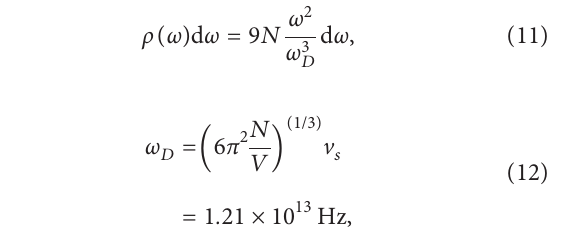
/ z R ) � 1 . 619 s − 1 , 〈 ζ 〉 � 156 . 5 , ( a / 〈 ζ 〉) � 0 . 85, is shown in blue and the TS